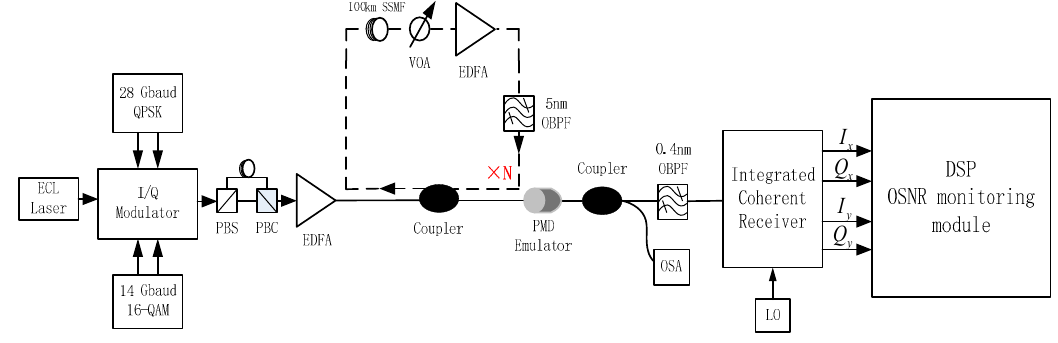
Figure 7. Experimental setup for OSNR monitoring in coherent receiver.